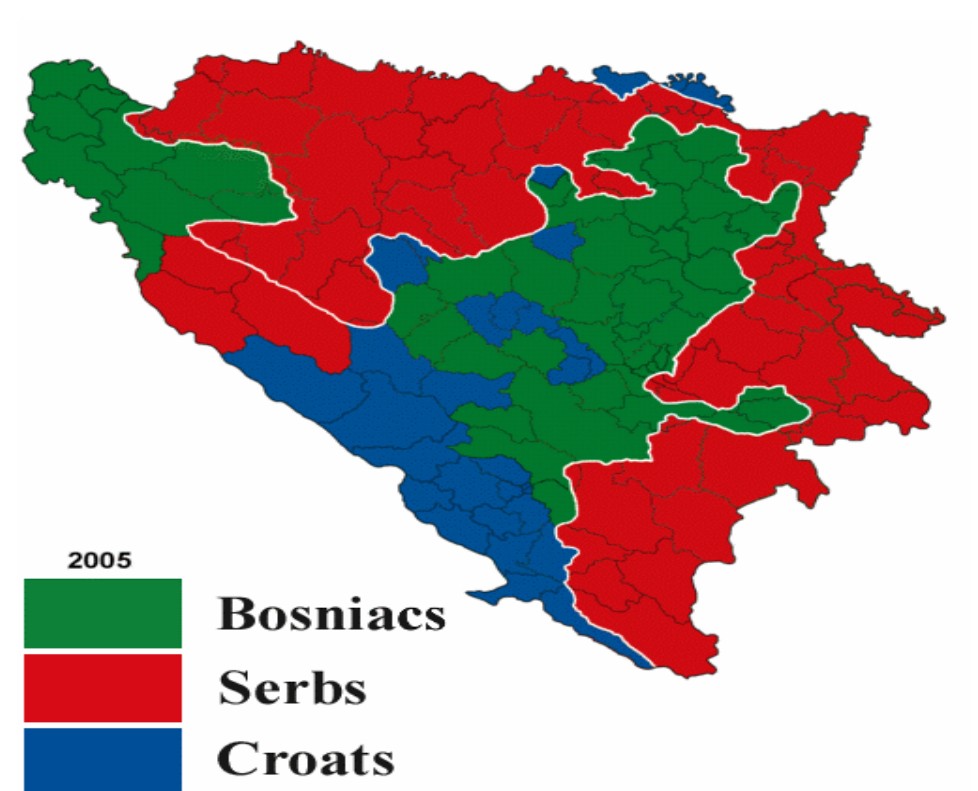
Fig. 2. Ethnic composition in Bosnia in 2005, after Dayton Peace Accord. Source: Čuvalo 2007, p.